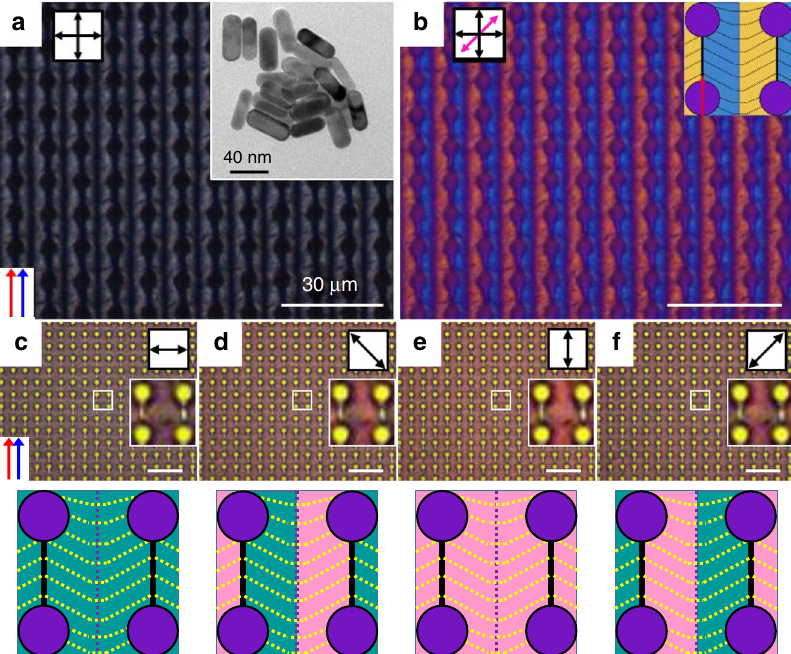
Fig. 5 Plasmonic DNA – gold nanorods fi lm fabricated on the microposts. a , b POM images without and with a fi rst-order retardation plate. The inset TEM image shows the dimensions of the PEG-modi fi ed gold nanorods. c – f Optical colour textures depending on the angle between a polariser and pulling direction show blue c , red e , and mixed colour d , f . Black scale bar represent 40 nm and white ones are 30 μ